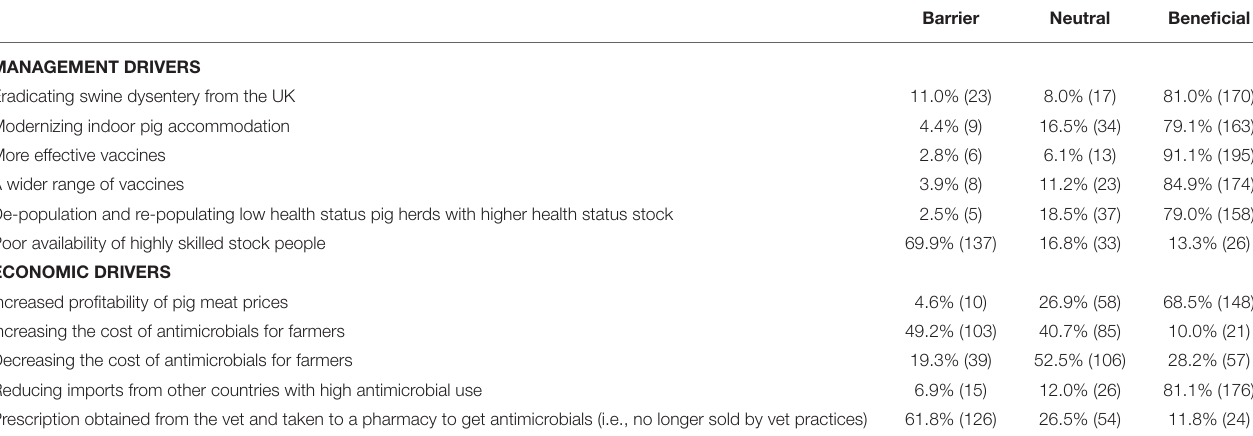
Barrier Neutral Beneficial